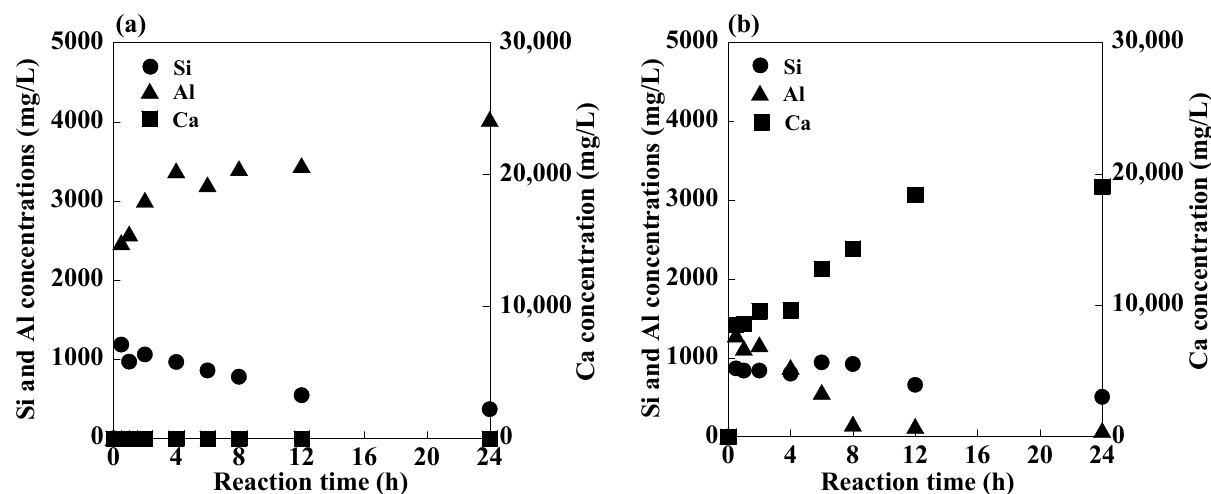
Figure 9. Concentrations of Si, Al, and Ca in the solution during synthesis at 80 °C: ( a ) without 1 M EDTA and ( b ) with 1 M EDTA (NaOH concentration: 3 M NaOH).